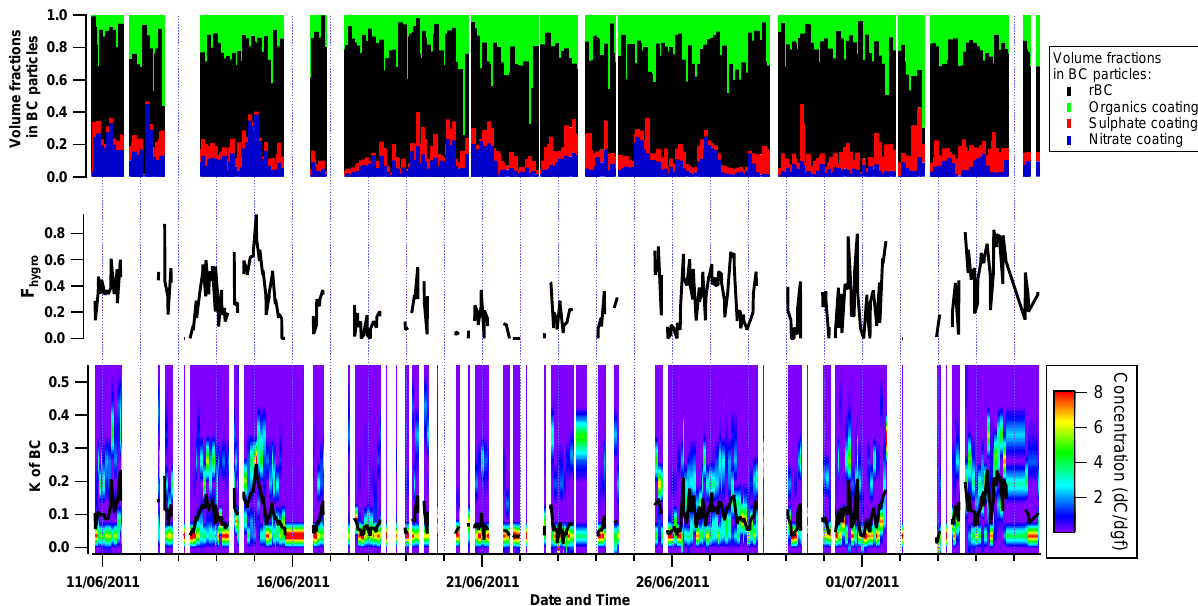
Fig. 6. Bottom panel: time series of the effective hygroscopicity parameter ( κ) distribution for BC-containing particles, the κ is calculated from inverted gf measured by the HTDMA-SP2; the black line shows the time series of the average κ from each scan. Middle panel: the number fraction of more-hygroscopic BC-containing particles. Top panel: the volume fractions in BC-containing particles contributed by different components (averaged over all BC-containing particles for each full HTDMA scan): refractory BC (rBC), organic matter coating, nitrate coating and sulphate